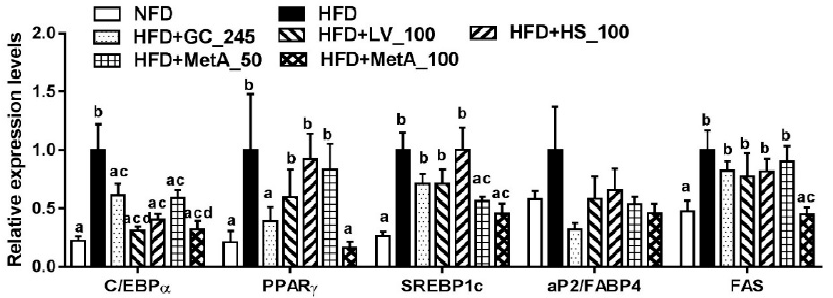
Figure 4. Effect of LV, HS, and MetA on expression of adipogenic regulator genes in HFD-induced obese mice. The mRNA expression levels of adipogenic regulator genes were analyzed using quantitative real-time polymerase chain reaction (qPCR). HFD, 60% high-fat-diet control group; HFD + GC_245, HFD contains Garcinia cambogia extract (245 mg/kg)-fed group; HFD + LV_100, HFD contains lemon verbena extract (100 mg/kg)-fed group; HFD + HS_100, HFD contains Hibiscus flower extract (100 mg/kg)-fed group; HFD + MetA_50, HFD contains the MetA-mixed extract of lemon verbena plus Hibiscus flower (50 mg/kg)-fed group; HFD + MetA_100, HFD contains the MetA-mixed extract of lemon verbena plus Hibiscus flower (100 mg/kg)-fed group. Values are expressed as means ± SEM ( n = 10). a–d Values within arrow with different letters are significantly different from each other at p < 0.05 as determined using Turkey’s multiple-range test.